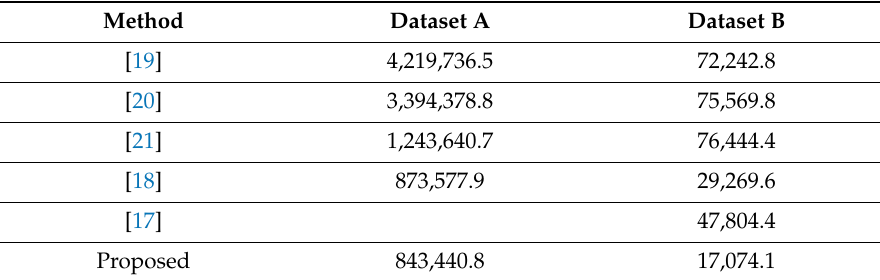
Table 6. Results general of segmentation. 372